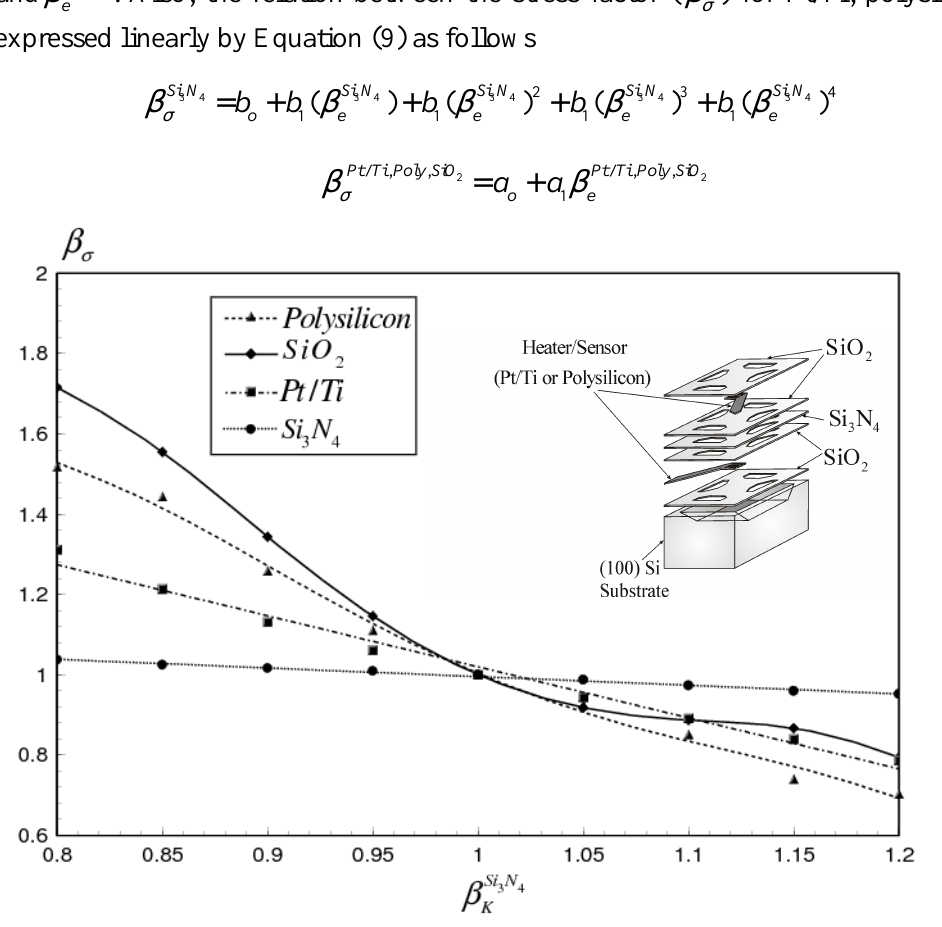
Figure 5. Effect of thermal conductivity variation of Si